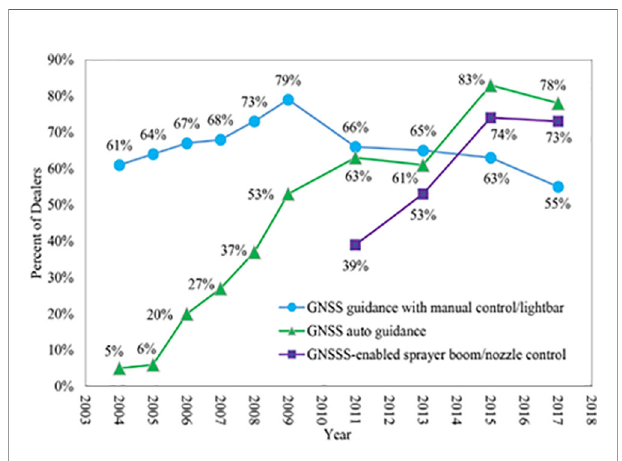
FIGURE 3 | US dealerships using Global Navigation Satellite Systems (GNSS) guidance and sprayer section controllers. 2004 to 2017. (Adopted from: DeBoer and Erickson,